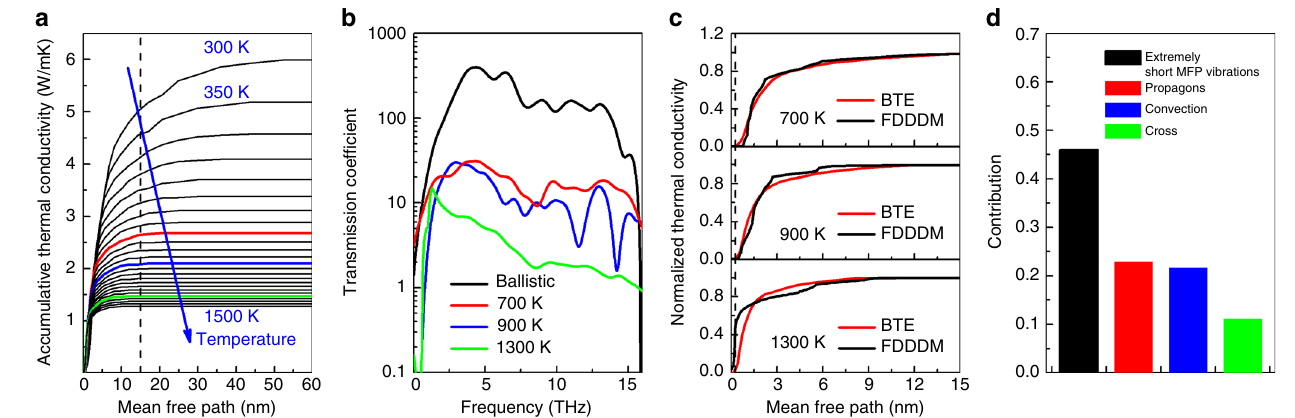
Fig. 4 Characterize four different heat carriers based on the mean free path (MFP) analysis. a Accumulative thermal conductivity versus MFP at different temperatures from fi rst principles calculations. b Frequency dependent transmission coef fi cient computed via Eq. (3). c Normalized accumulative thermal conductivity versus MFP from fi rst principles, i.e., Boltzmann transport equation (BTE), and frequency-dependent direct decomposed method (FDDDM) (reactive force fi led molecular dynamics) simulations. The black dashed line indicates the distance between the nearest neighbors. d Comparison of